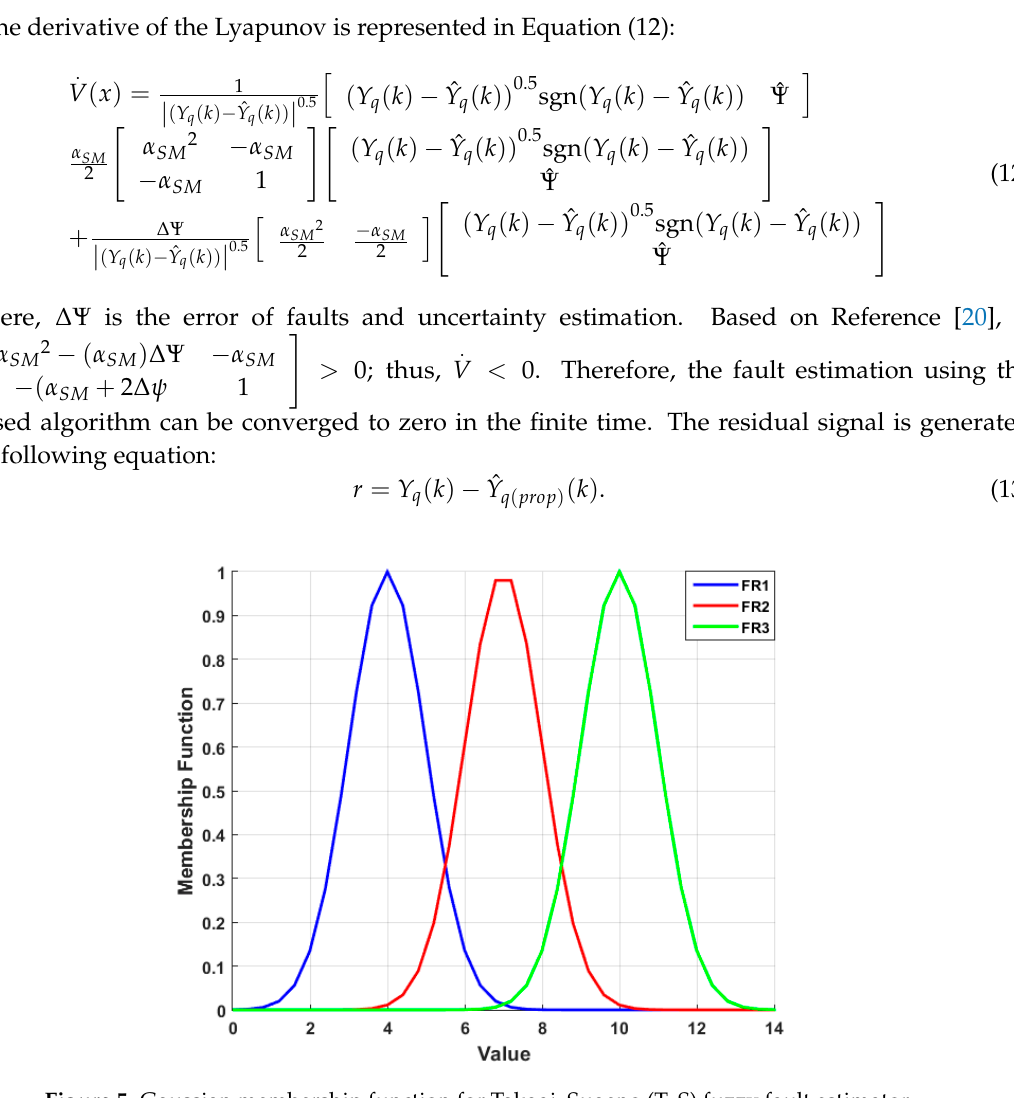
Figure 5. Gaussian membership function for Takagi–Sugeno (T–S) fuzzy fault estimator.